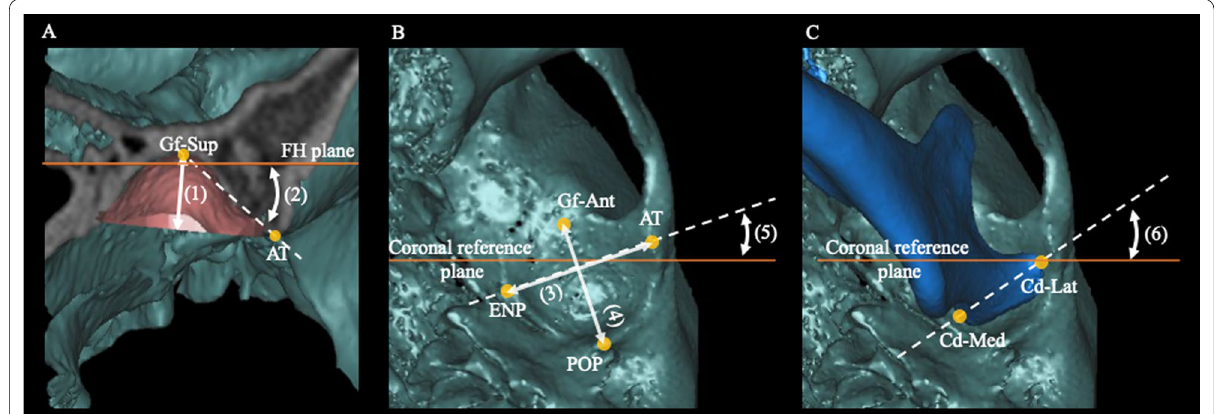
Fig. 3 Linear and angular measurements for the evaluation of temporomandibular joint morphology. A : The glenoid fossa depth was defined as the perpendicular distance from the most superior point of the glenoid fossa (Gf‑Sup) to the glenoid fossa base (1). The articular eminence angle (AE angle) was defined as the angle between the tangent line connecting Gf‑Sup‑AT and the Frankfort horizontal plane (FH) (2). B : The glenoid fossa width was defined as the distance between AT and ENP (3) and the glenoid fossa length was defined as the distance between POP and the most anterior point of the glenoid fossa base (4). The axial glenoid fossa angle was defined as the angle between the line connecting ENT‑AT and the coronal reference plane (5). C : The axial condylar angle was defined as the angle between the horizontal condylar axis (Cd‑Med–Cd‑Lat) and the coronal reference plane (6)